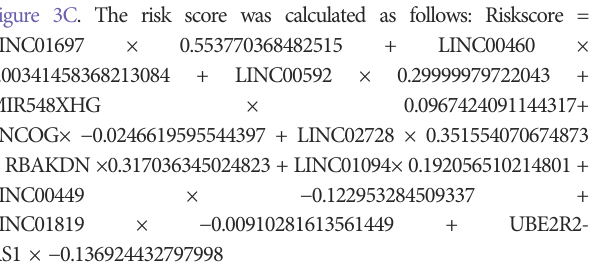
scores for STAD had a lower likelihood of survival, as depicted in Figure 4B. K-M survival analysis found that high-risk patients ( p < 0.001) had a considerably shortened OS duration, as depicted in Figure 4C. Similar patterns of expression, risk, and survival were observed between the test and composite groups and the training set (Figures 4D, E, G, H). Furthermore, high-risk individuals had substantially shorter OS duration in both the test ( p = 0.001) and combined groups ( p < 0.001). These all validate the accuracy of this prognostic model. This study further explored the precision of